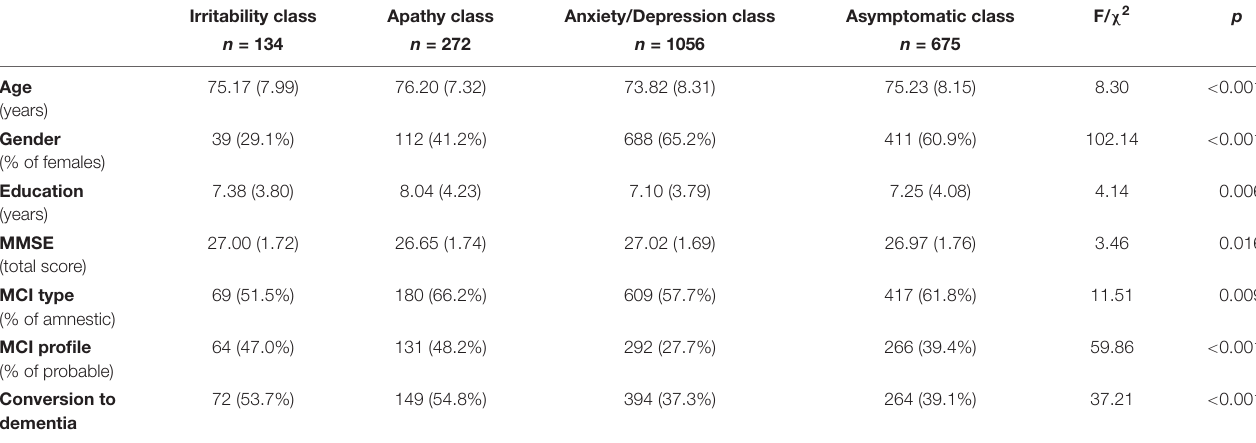
TABLE 1 | Demographic characteristics and clinical variables of our final sample ( n = 2137) stratified by neuropsychiatric symptoms cluster (NPS